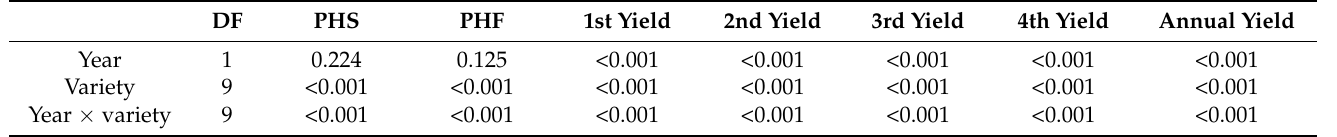
Table 1. The two-way ANOVA p -values for main effects and interactions of year and cultivar on alfalfa yield and plant height.